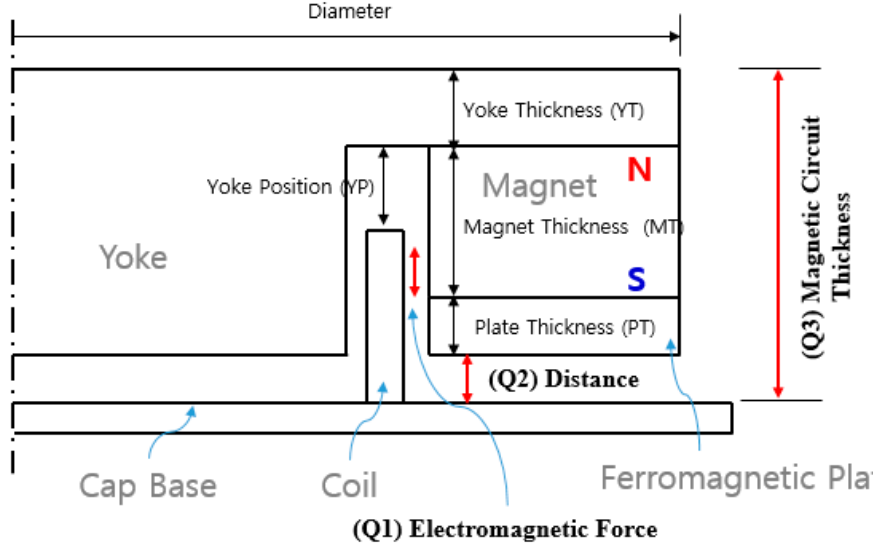
Figure 9. Objective function of magnetic circuit.